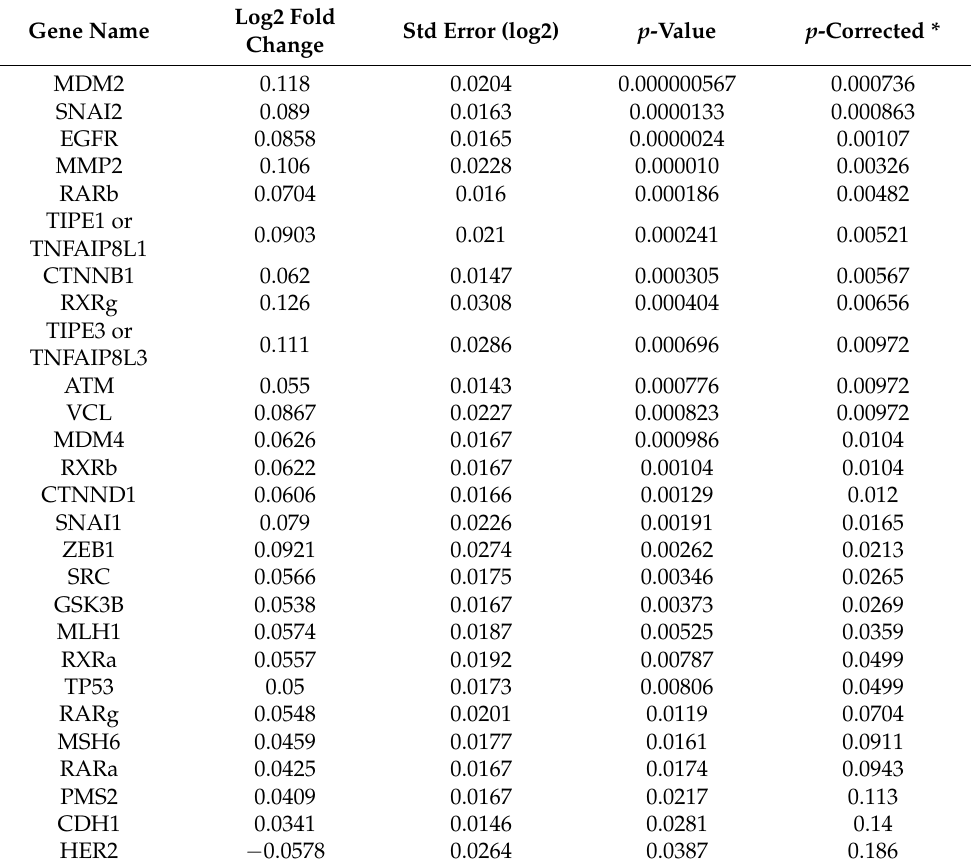
Table 5. Fold change mRNA gene expression associated with increased serum PGII levels.